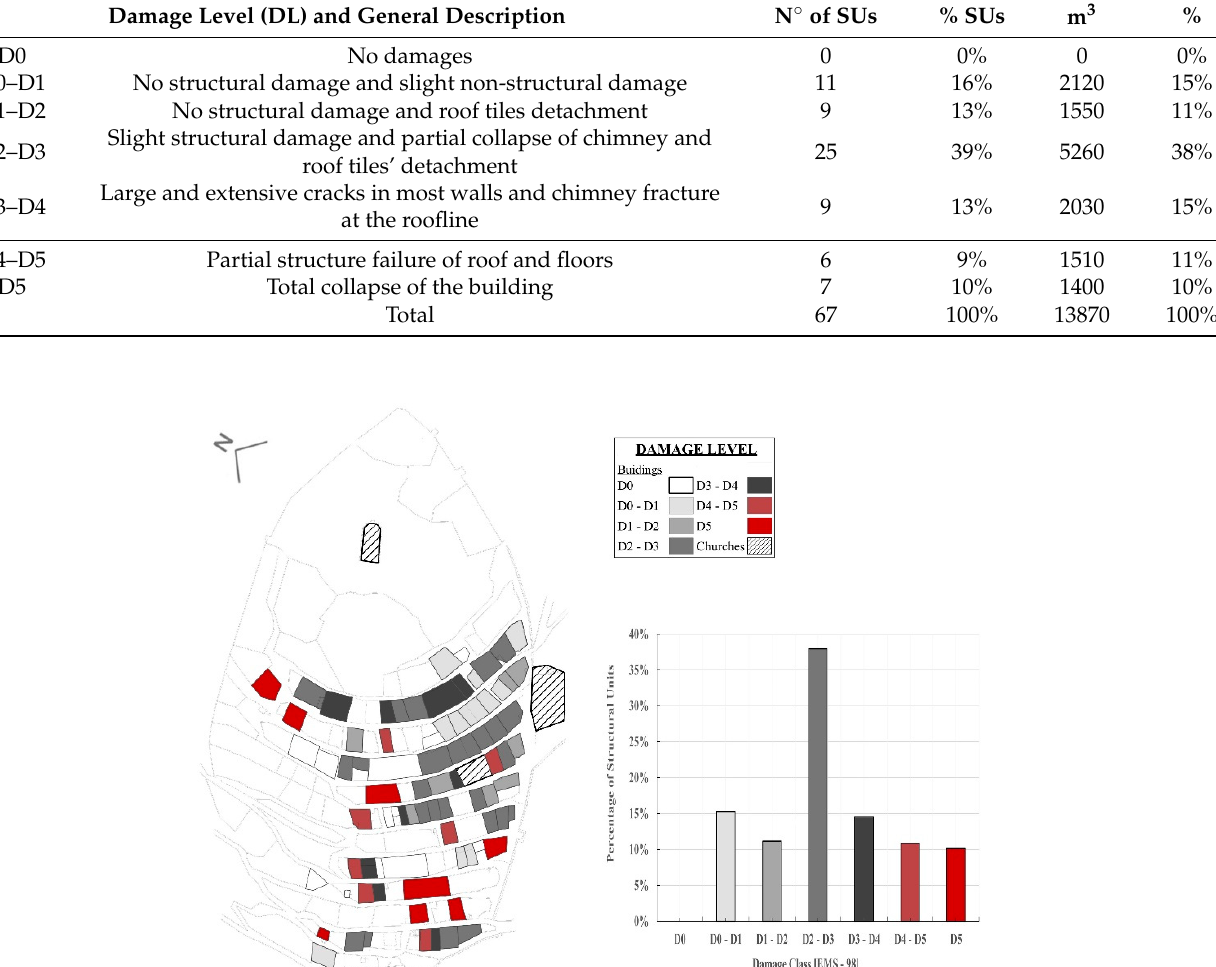
Figure 6. Mapping of the damage observed in Campi Alto di Norcia, according to the European Macroseismic Scale (EMS)98.